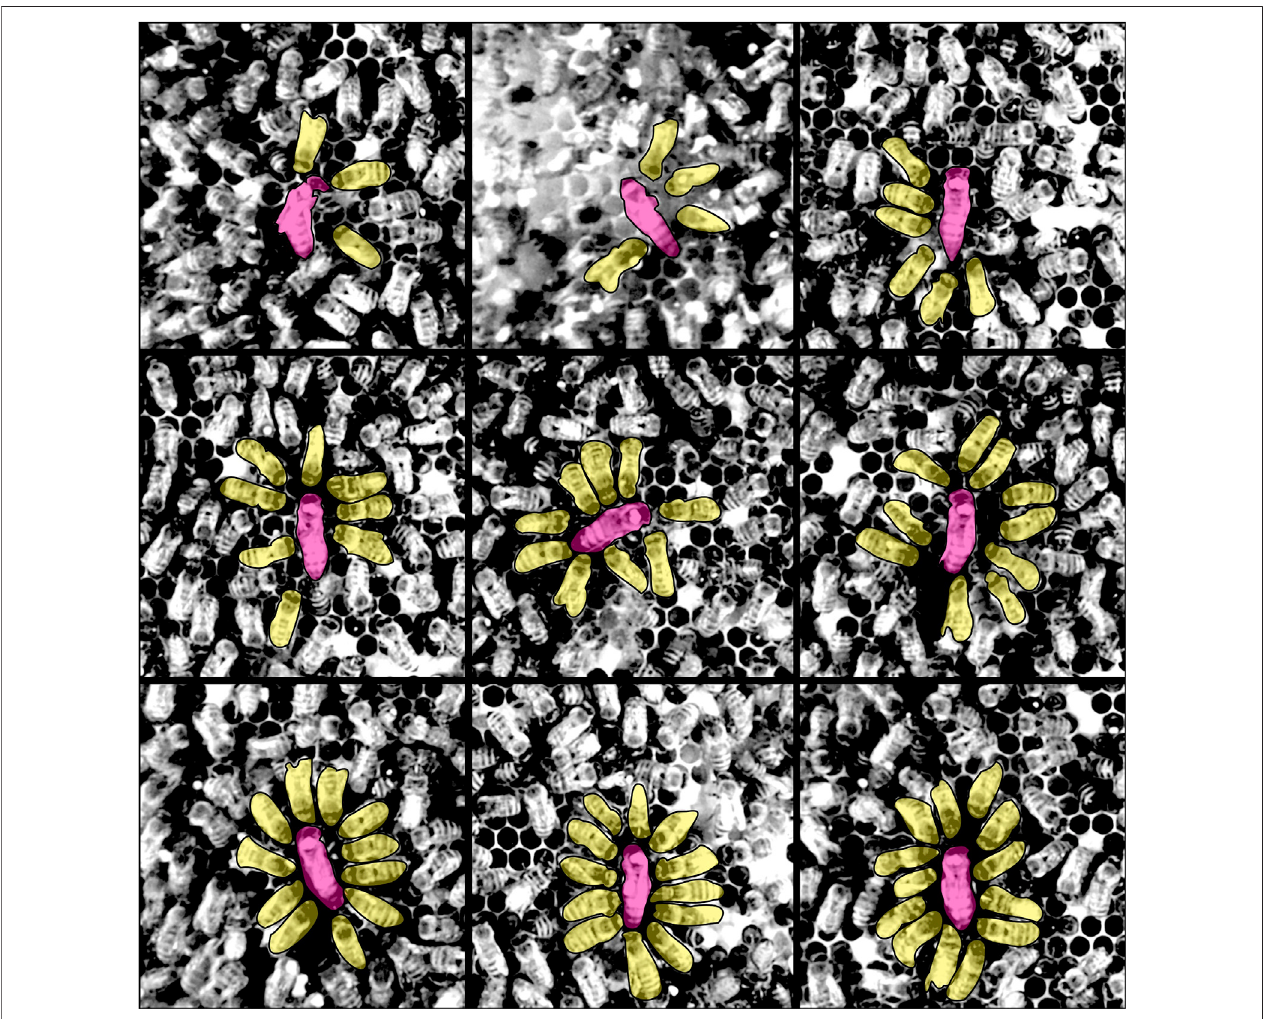
FIGURE 5 | Sample observed queen court events of various sizes. 9 exemplary queen court events with increasing number of attending bees from top left to bottom right. The queen (pink) and the court worker bees (yellow) are highlighted to indicate the court visually.